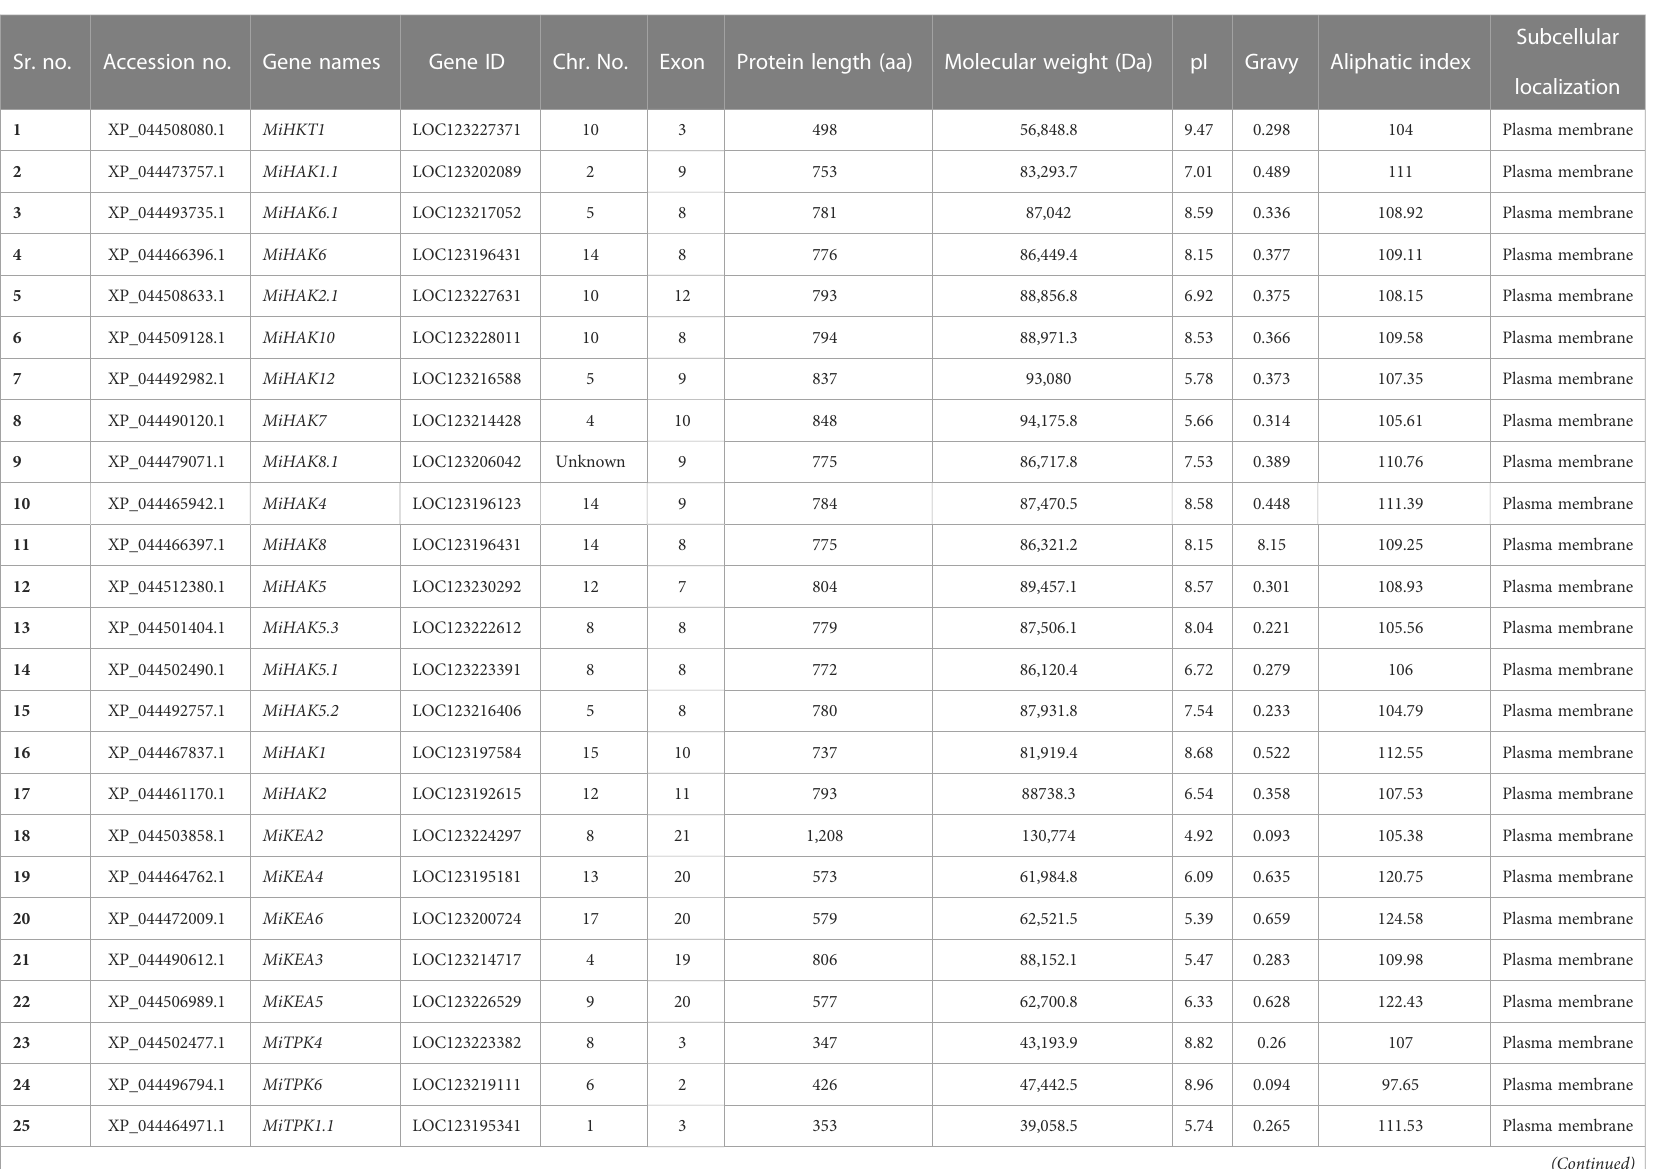
TABLE 1 Physiochemical properties of K + transport-related genes in Mangifera indica .